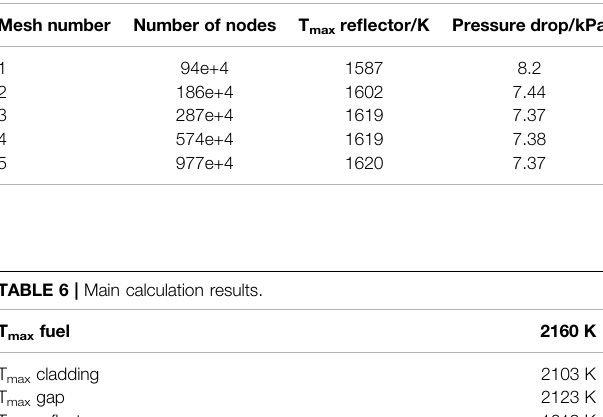
TABLE 5 | Main calculation results of different meshes.